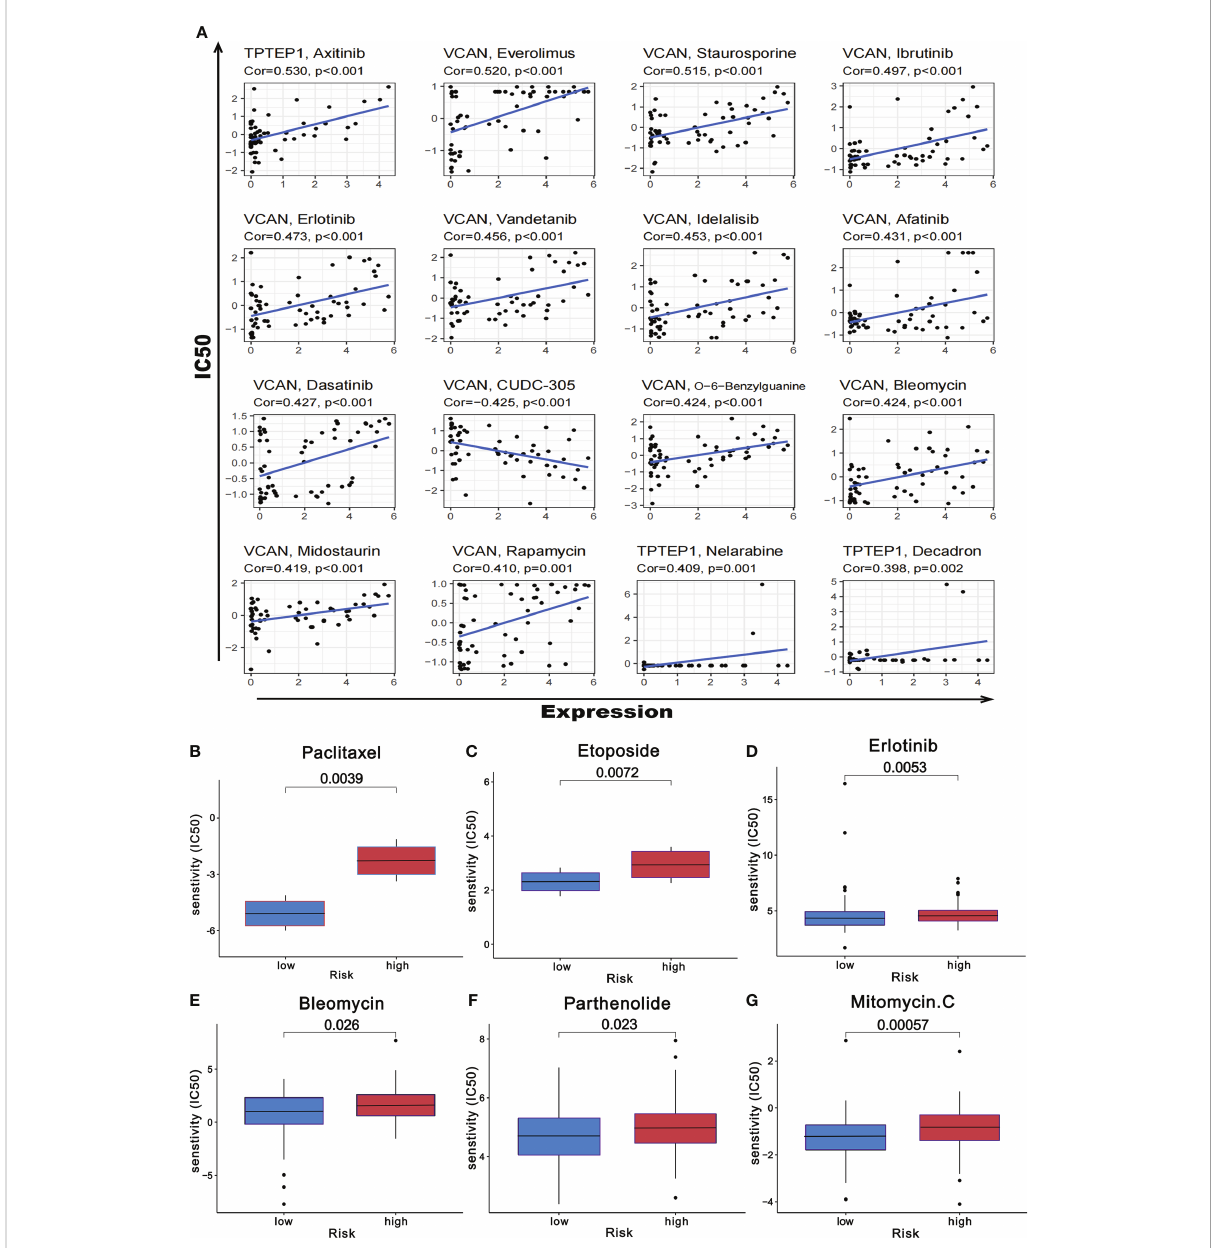
FIGURE 11 Prediction of chemotherapeutic drug resistance in gastric cancer by comprehensive prognosis model. (A) Correlation between fi ve RNAs and chemotherapeutic drug resistance in gastric cancer. (B-G) The risk score obtained by the comprehensive model can predict the drug resistance of six common chemotherapeutic